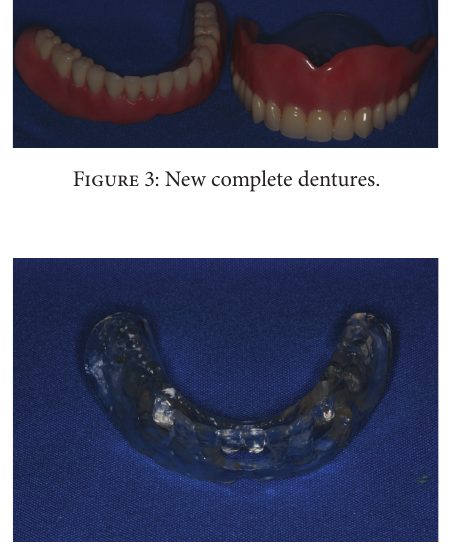
Figure 4: Surgical guide.